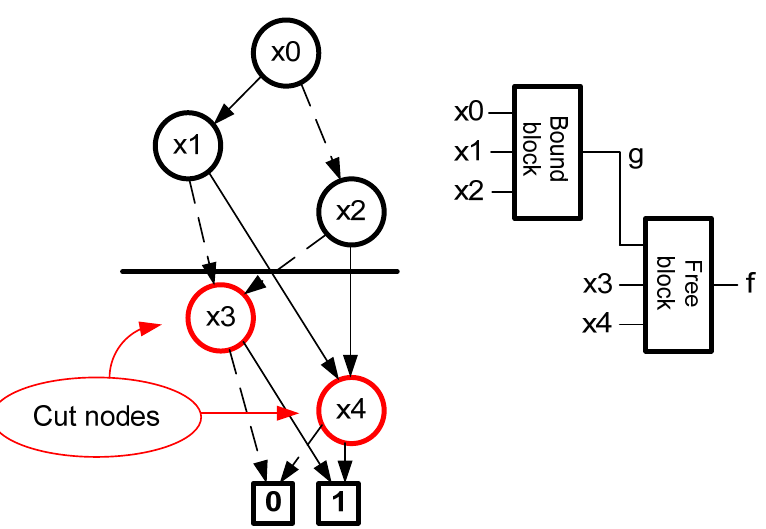
Figure 2. Performing decomposition using BDD.